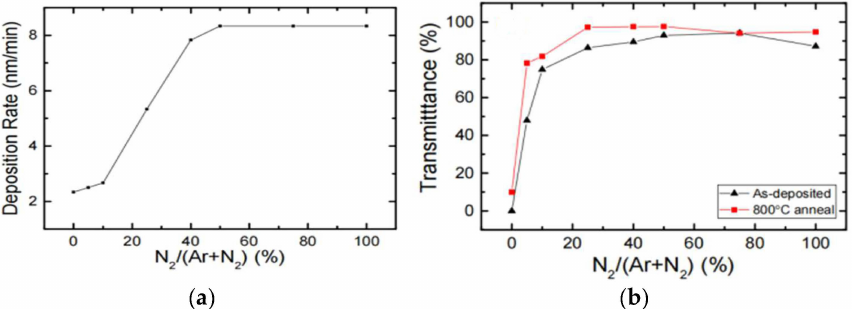
Figure 21. ( a ) Deposition rate as a function of N 2 /(N 2 + Ar) gas flow ratio. ( b ) Optical transmittance at 265 nm for hexagonal boron nitride (h-BN) films and various N 2 /(N 2 + Ar) flow ratios before and after post-annealing treatments at 800 ◦ C